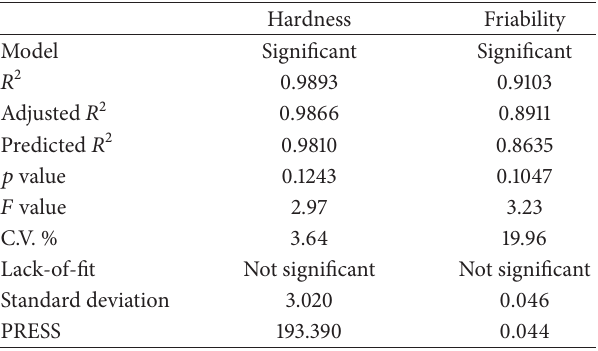
Table 4: Data from analysis of variance (ANOVA) for hardness and friability of okara